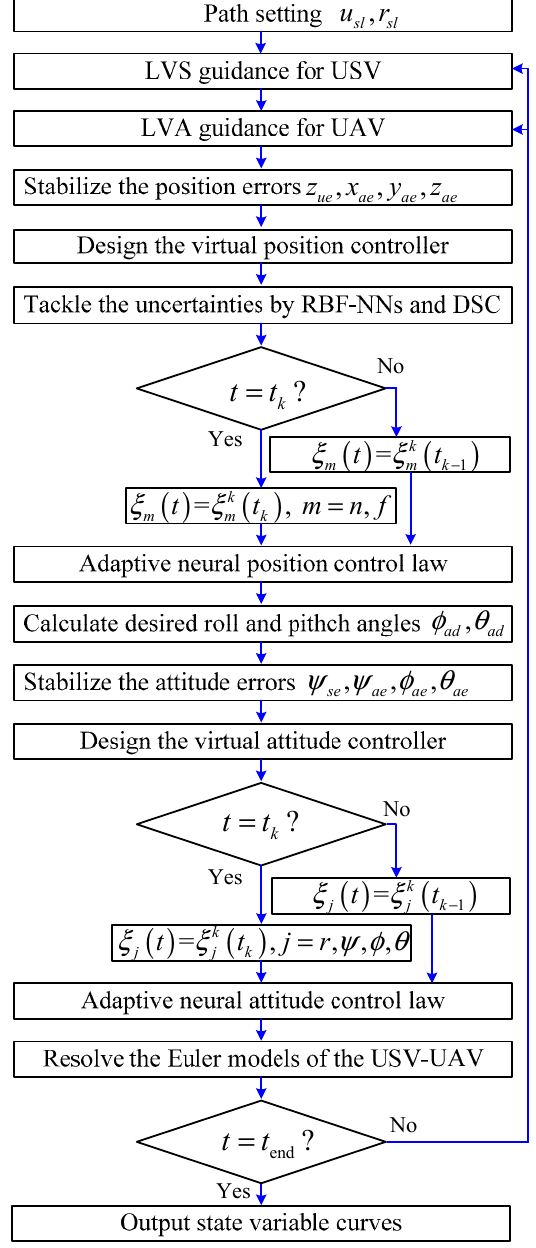
Figure 3. The control diagram of the proposed algorithm.